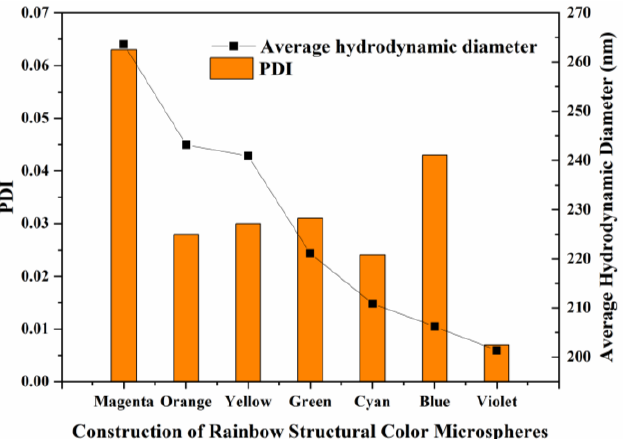
Figure 13. DLS characterization of PSt microspheres for rainbow structural color coatings.